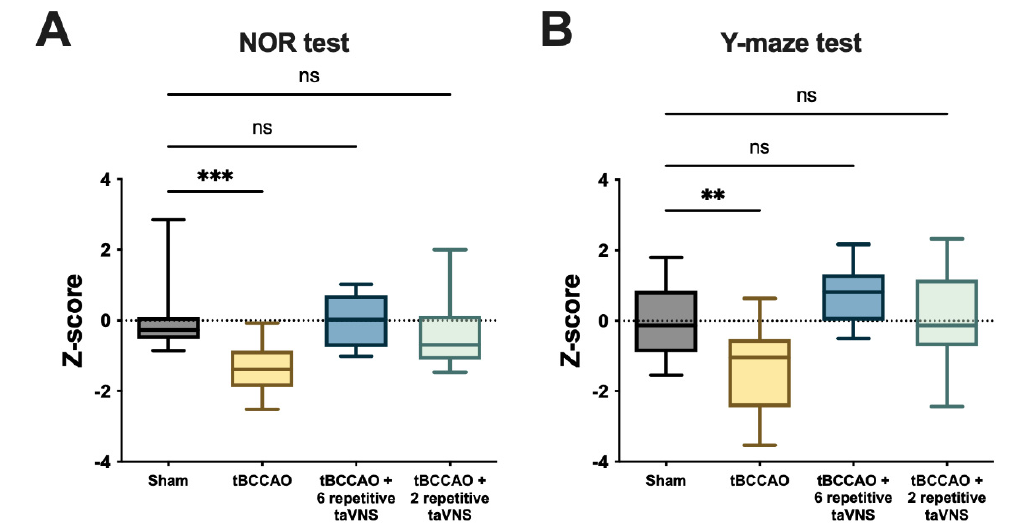
Figure 6. The effect sizes of both six and two repetitive days of treatment were similar. Z − score representing the size of the effect, normalized by the average and standard deviation of the sham group, was adopted to compare each group. ( A ) In the NOR test, the group that received six repetitions of taVNS (deep blue, n = 8) and the group that received two repetitions of taVNS (light blue, n = 13) showed similar Z − scores to that of the sham group (gray, n = 12). The tBCCAO group had a significantly lower Z − score of tBCCAO (yellow, n = 25; p < 0.001). ( B ) Similar to the NOR test results, in the Y − maze test, the group that received six repetitions of taVNS (deep blue, n = 8) and the group that received two repetitions of taVNS (light blue, n = 11) showed similar Z − scores to that of the sham group (gray, n = 36). The tBCCAO group had a significantly lower Z − score of tBCCAO (yellow, n = 15; p = 0.001). The error bars indicate the SEM. One − way repeated measures ANOVA with the post hoc Dunnett test was used. ** p < 0.01; *** p < 0.001; ns, not significant.